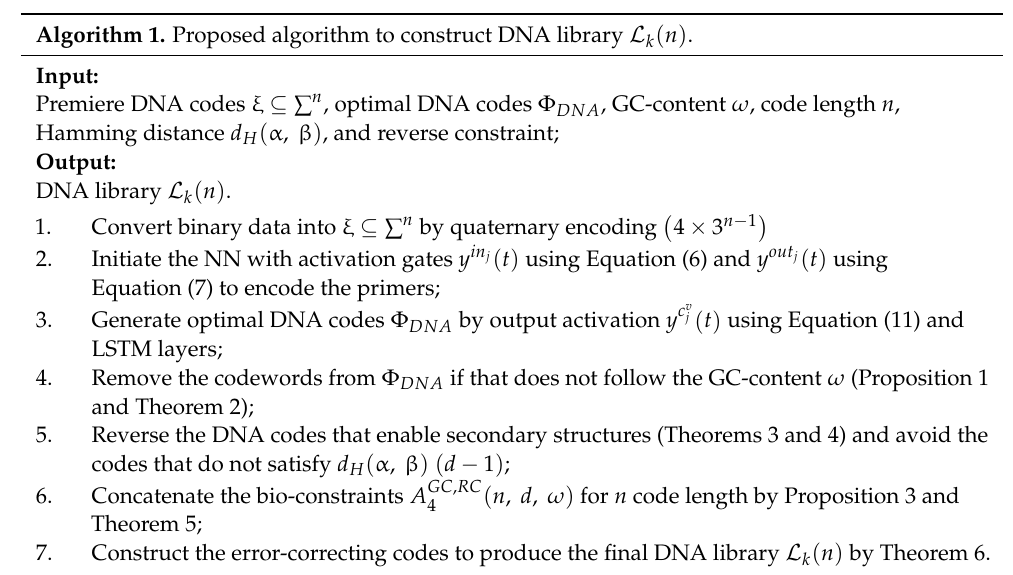
Algorithm 1. Proposed algorithm to construct DNA library L k ( n ) .